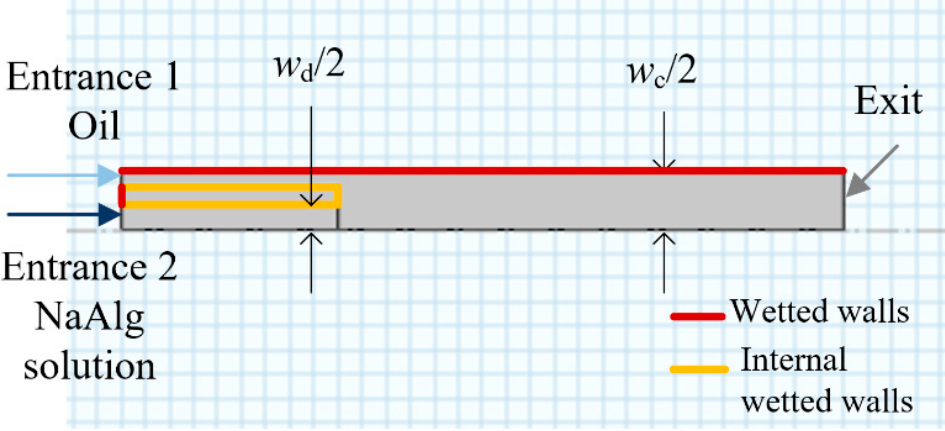
Figure 3. Two-dimensional axisymmetric geometric structure of the microchannel.